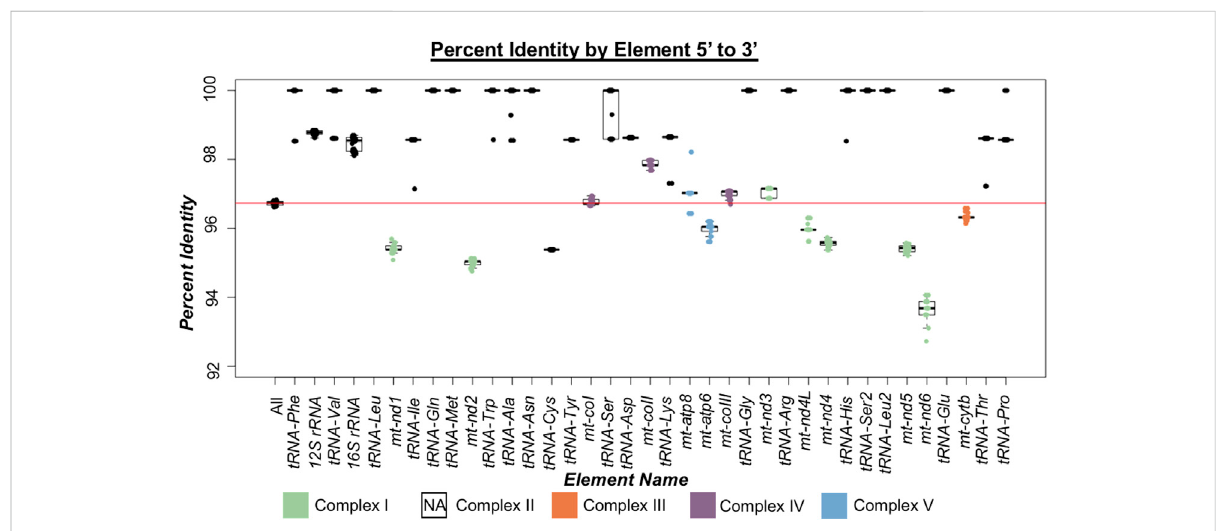
FIGURE 2 Percent identity of mitogenomic elements 5 ′ to 3 ′ in threespine stickleback ( Gasterosteus aculeatus ). Box plots indicate the range of percent identity between the Trans-North-Paci fi c (TNP) reference genome from North America and Euro-North American (ENA) mitogenomes from North America. The fi rst box plot represents the percent identity across the whole mitogenome (excluding the control region). Box plots for each genic element areordered basedon their5 ′ to 3 ′ orientation. Protein coding genesarecolored based onwhich oxidative phosphorylation (OXPHOS) complex they comprise. Complex II of OXPHOS does not contain mitochondrially encoded proteins and therefore not represented indicated by NA (not applicable). The red horizontal line indicates average mitogenomic percent